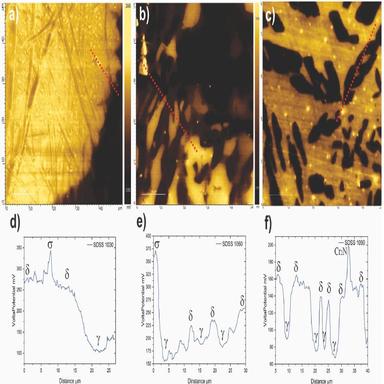
Kelvin probe force microscopy images in heat-treated SDSS-Nb, a) KPFM SDSS-Nb 1030; b) KPFM SDSS-Nb 1060; c) SKPFM SDSS-Nb 1090; d) KPFM SDSS-Nb 1030 VoltaPotential Profile; e) KPFM SDSS-Nb 1060 VoltaPotential Profile; f) KPFM SDSS-Nb 1090 VoltaPotential Profile.